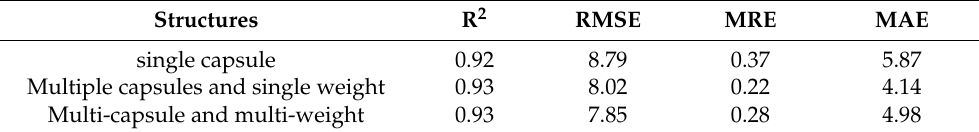
Table 5. The results of different capsule structures.